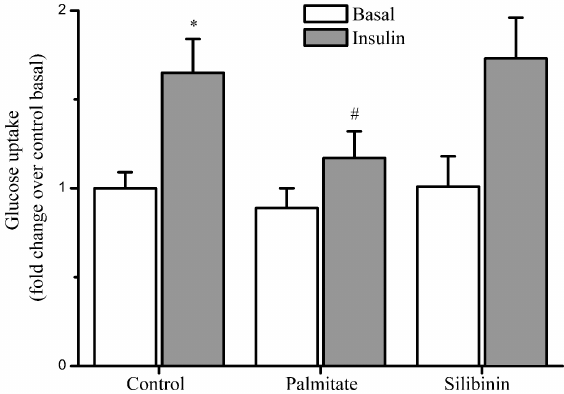
Figure 1. Effects of chronic exposure of C2C12 skeletal muscle cells to silibinin or palmitate on glucose uptake. Myotubes were incubated for 16 h in growth medium supplemented with 100 m g/ mL silibinin or 0.75 mM palmitate, and then left untreated or stimulated with 100 nM insulin, followed by assessment of 2- NBDG uptake as described in Methods. Data are reported as means±SD of 4 determinations. *P , 0.05, compared to control basal values; # P , 0.05, compared to control group treated with acute insulin (Student’s t -test).